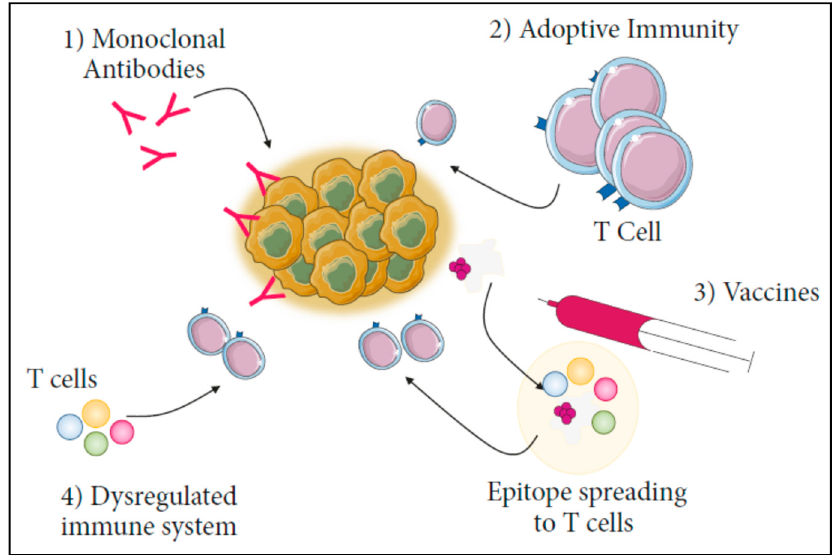
Figure 2. Currently available immunotherapy techniques. (1) Monoclonal antibodies, (2) Adoptive immunity, (3) Vaccines, and (4) Dysregulated immune system. These approaches are useful in evoking an immune response against cancers [22]. CC BY 4.0.